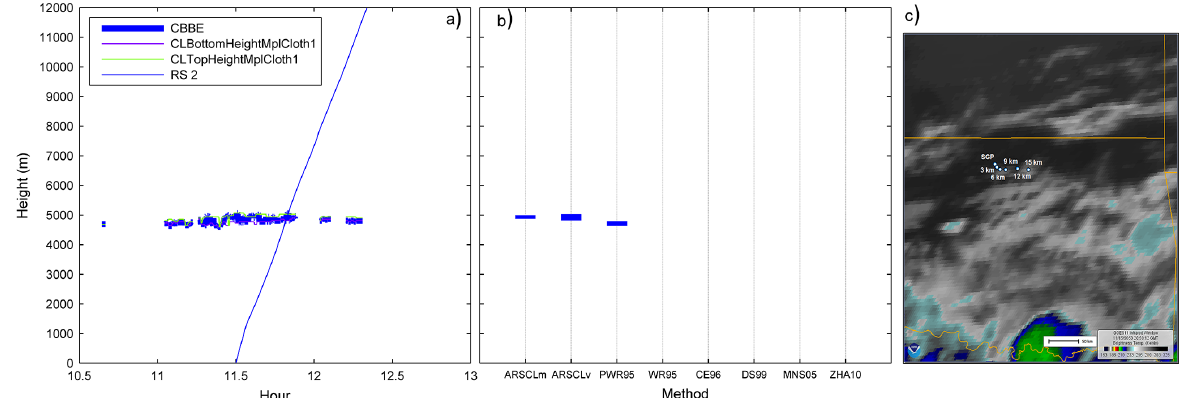
Figure 5. Idem as Fig. 3, but for Case 3: 10 July 2009, middle clouds. RS launch time: 11:30UTC). GOES infrared image at 12:00UTC.